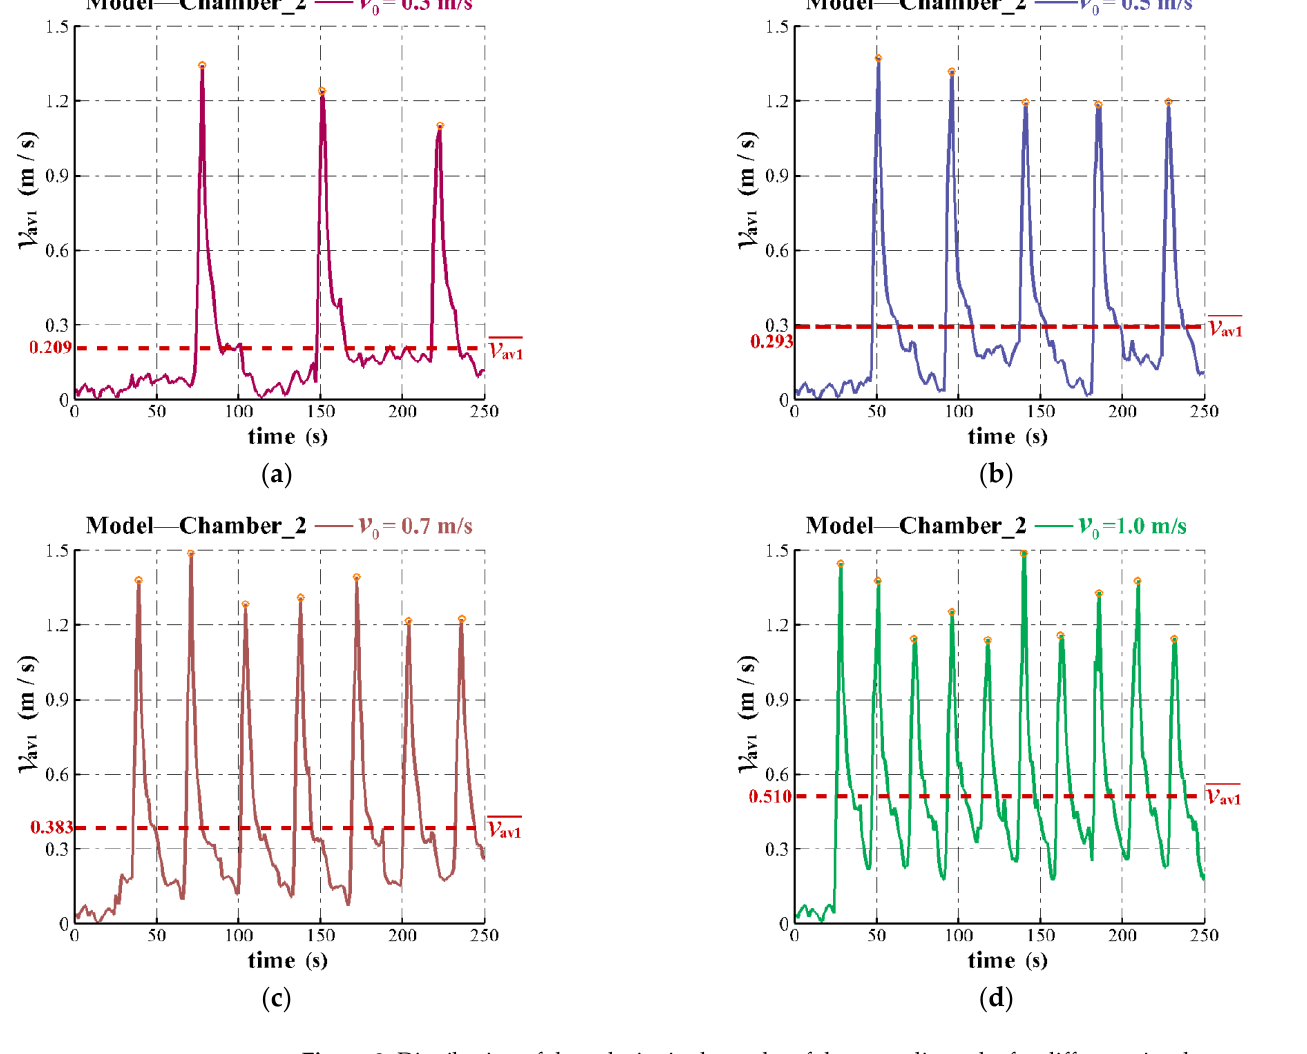
Figure 8. Distribution of the velocity in the outlet of the ascending tube for different air release rates of ( a ) 0.3, ( b ) 0.5, ( c ) 0.7, and ( d ) 1.0 m/s. The orange circles indicate the maximum velocities, and the red dashed lines indicate time-averaged velocities of the ascending tube